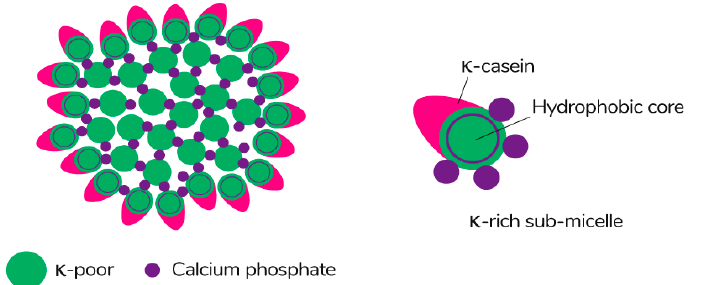
Figure 7. The schematic of the submicelle model of the casein micelle [117]. Reproduced with permission from Horne, D.S., Current Opinion in Colloid & Interface Science; published by Elsevier Ltd., 2005.